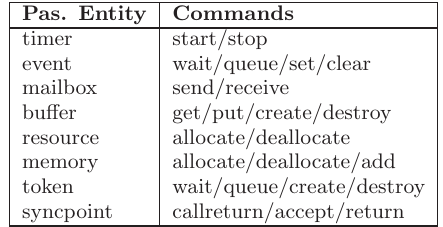
Table 1: ServiceRequestPlus attribute options